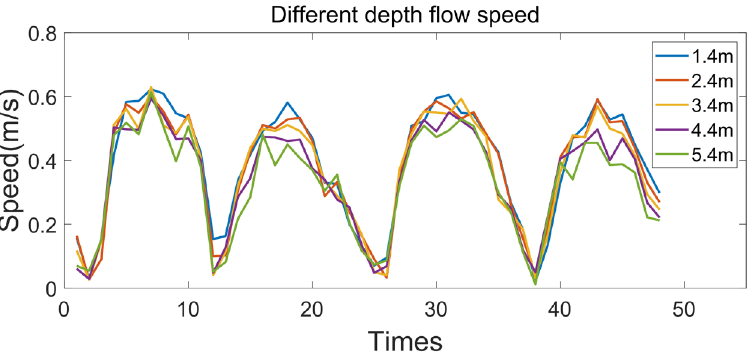
14 of 18 Figure 20. AUV and MANUAL depth-temperature comparison. Figure 21. AUV and MANUAL measurement time comparisons.